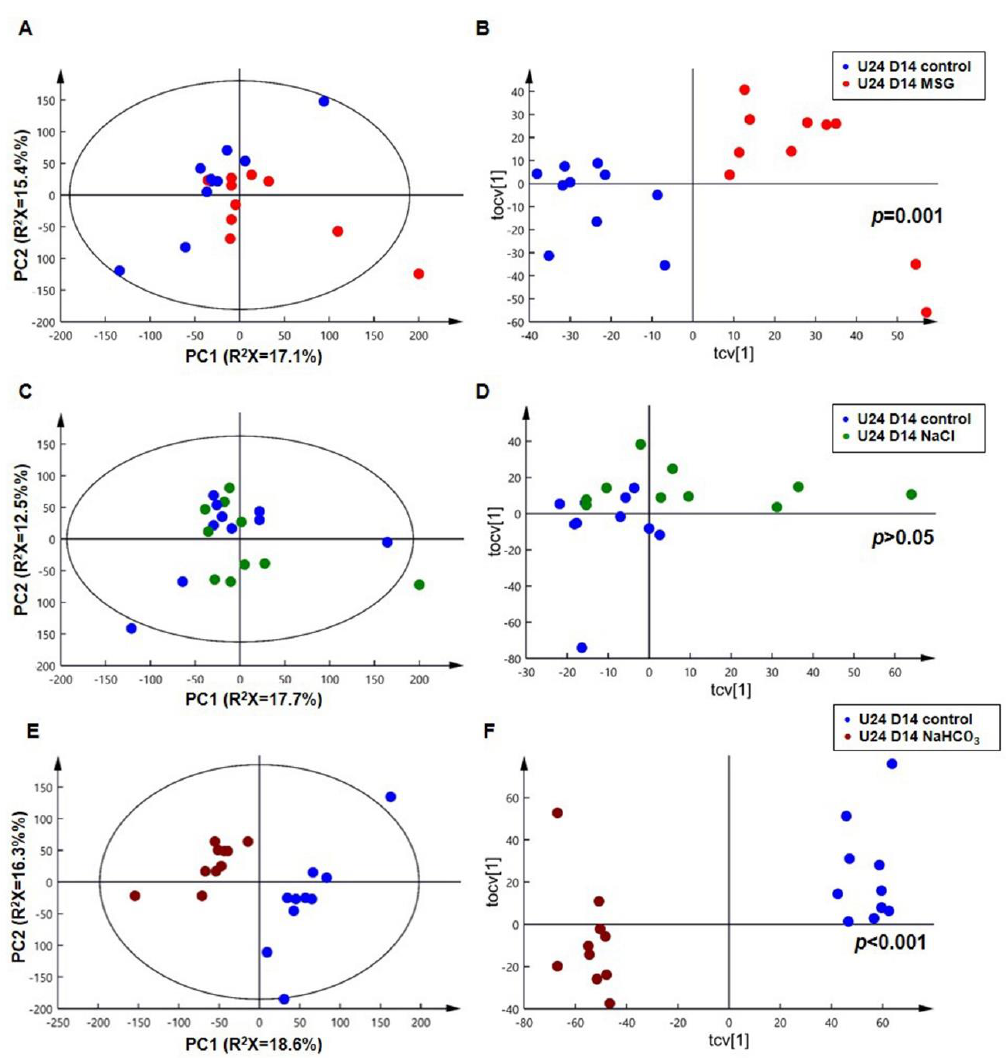
Figure 5. PCA scores plots (left panel) and O-PLS-DA cross-validated scores plots (right panel) of 24-h urine at day 14 (U24 D14). ( A , B ): control (blue) vs. MSG (red); ( C , D ): control (blue) vs. NaCl (green); ( E , F ): control (blue) vs. NaHCO 3 (brown) ( n = 10 per group).